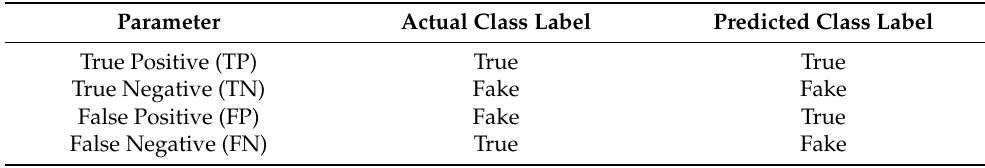
Table 1. Detail of the Evaluation